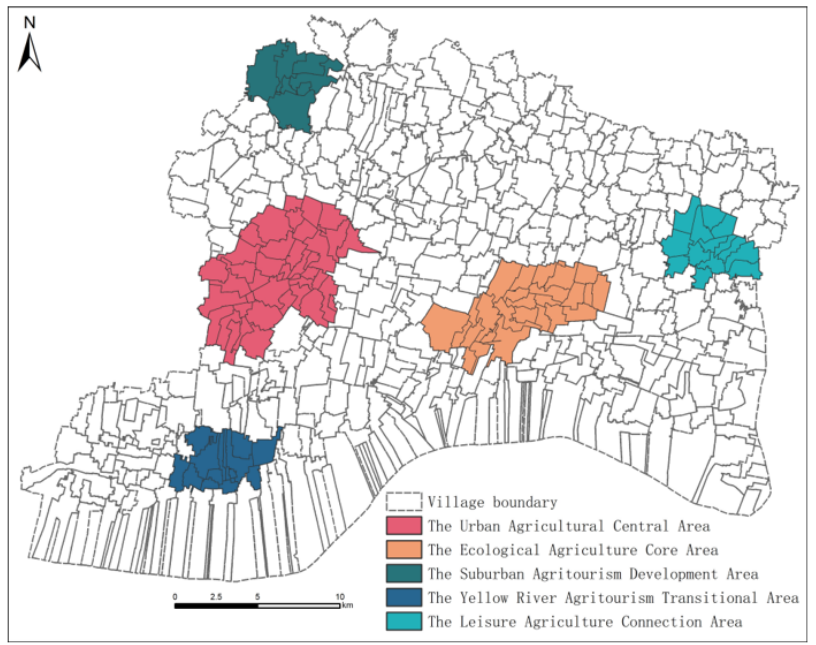
Figure 6. Zoning of the hot spots of the cultivated land leisure service function in Yuanyang County.